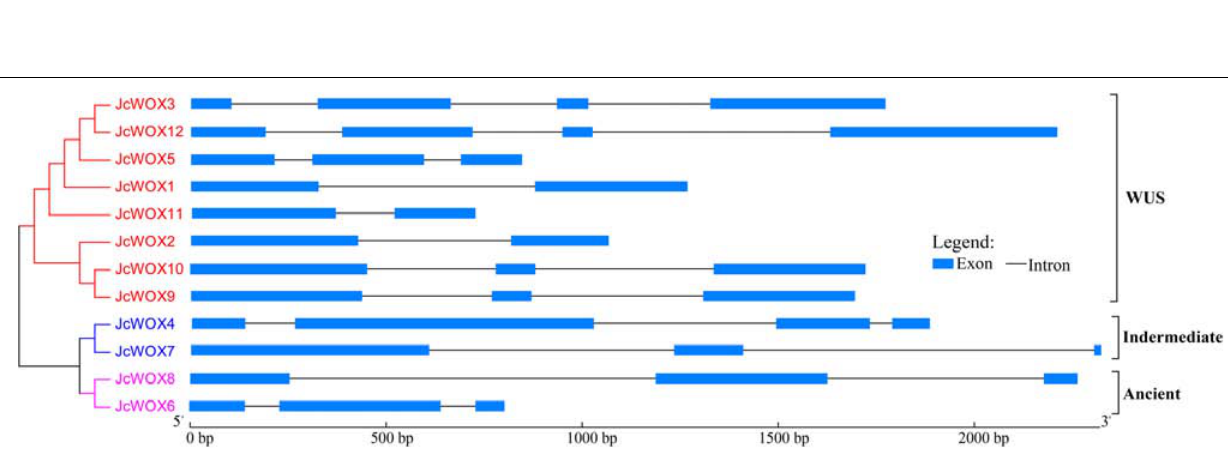
Frontiers in Genetics |